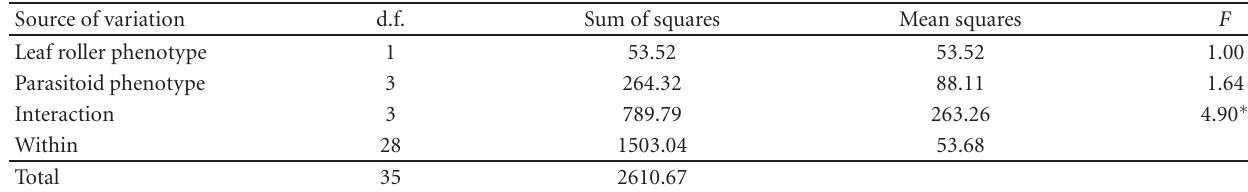
Table 2: Results of two-way ANOVA on the parasitoid body lengths variation in dependence from the parasitoid femur phenotype and the host insect pupa coloring (see Figure 5).